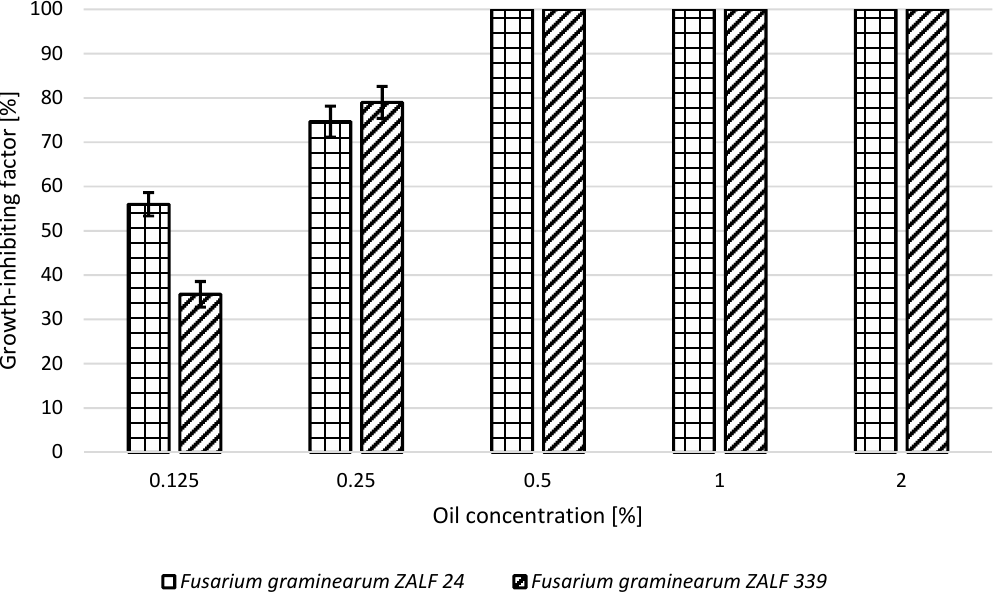
Figure 2. Growth-inhibiting factor of Fusarium graminearum ZALF 24 and Fusarium graminearum ZALF 339 strains in the presence of rosemary oil.